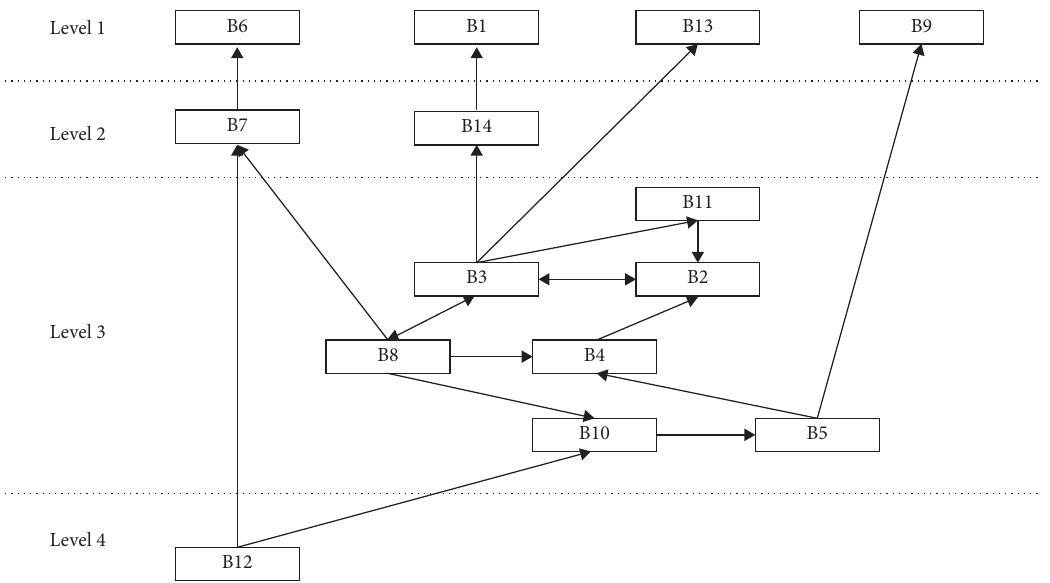
Figure 3: ISM of factors influencing the capability of general contractor.